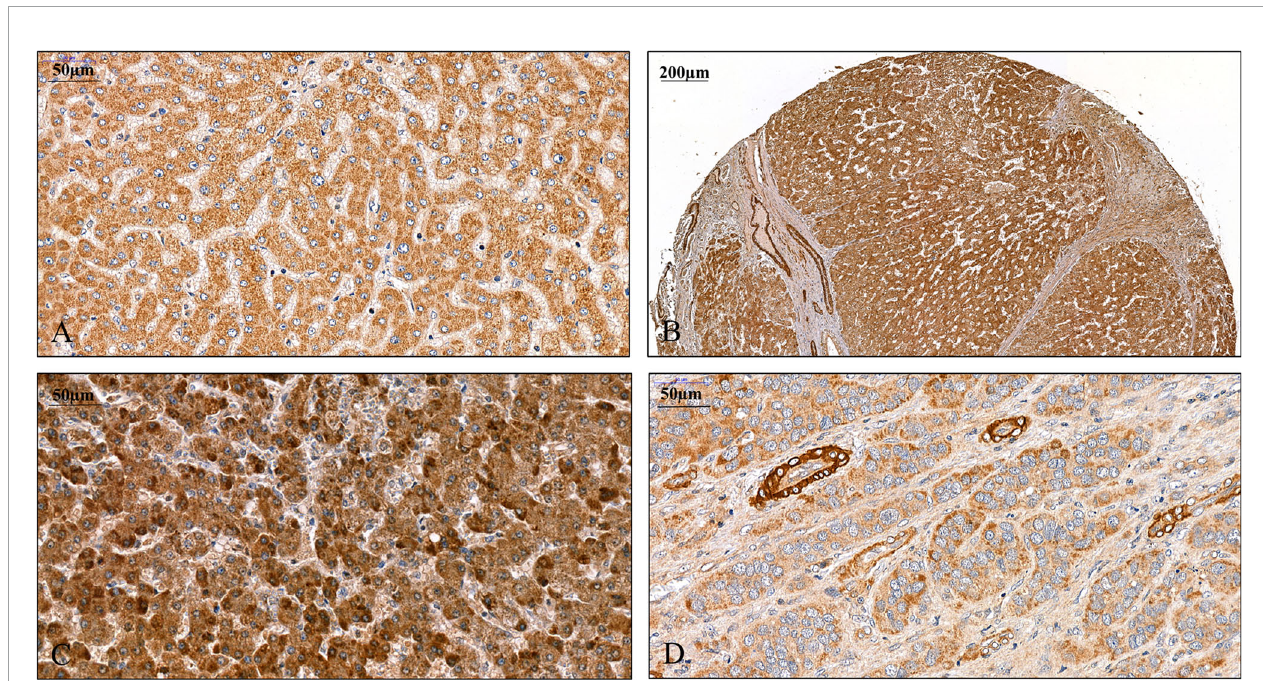
FIGURE 1 | Detection of SPOCK1 protein on human liver specimens. (A) Normal liver, moderate staining in the cytoplasm of hepatocytes. (B) Cirrhotic liver with intensive staining in the cytoplasm. Endothelial cells of the blood vessels also show the presence of high levels of SPOCK1. Areas of connective tissue are devoid of SPOCK1. (C) Hepatocellular carcinoma, the tumor cells are loaded with the proteoglycan. (D) Hepatocellular carcinoma, the staining intensity is modest in tumor cells, whereas the cytoplasm of endothelial cells shows high protein levels.